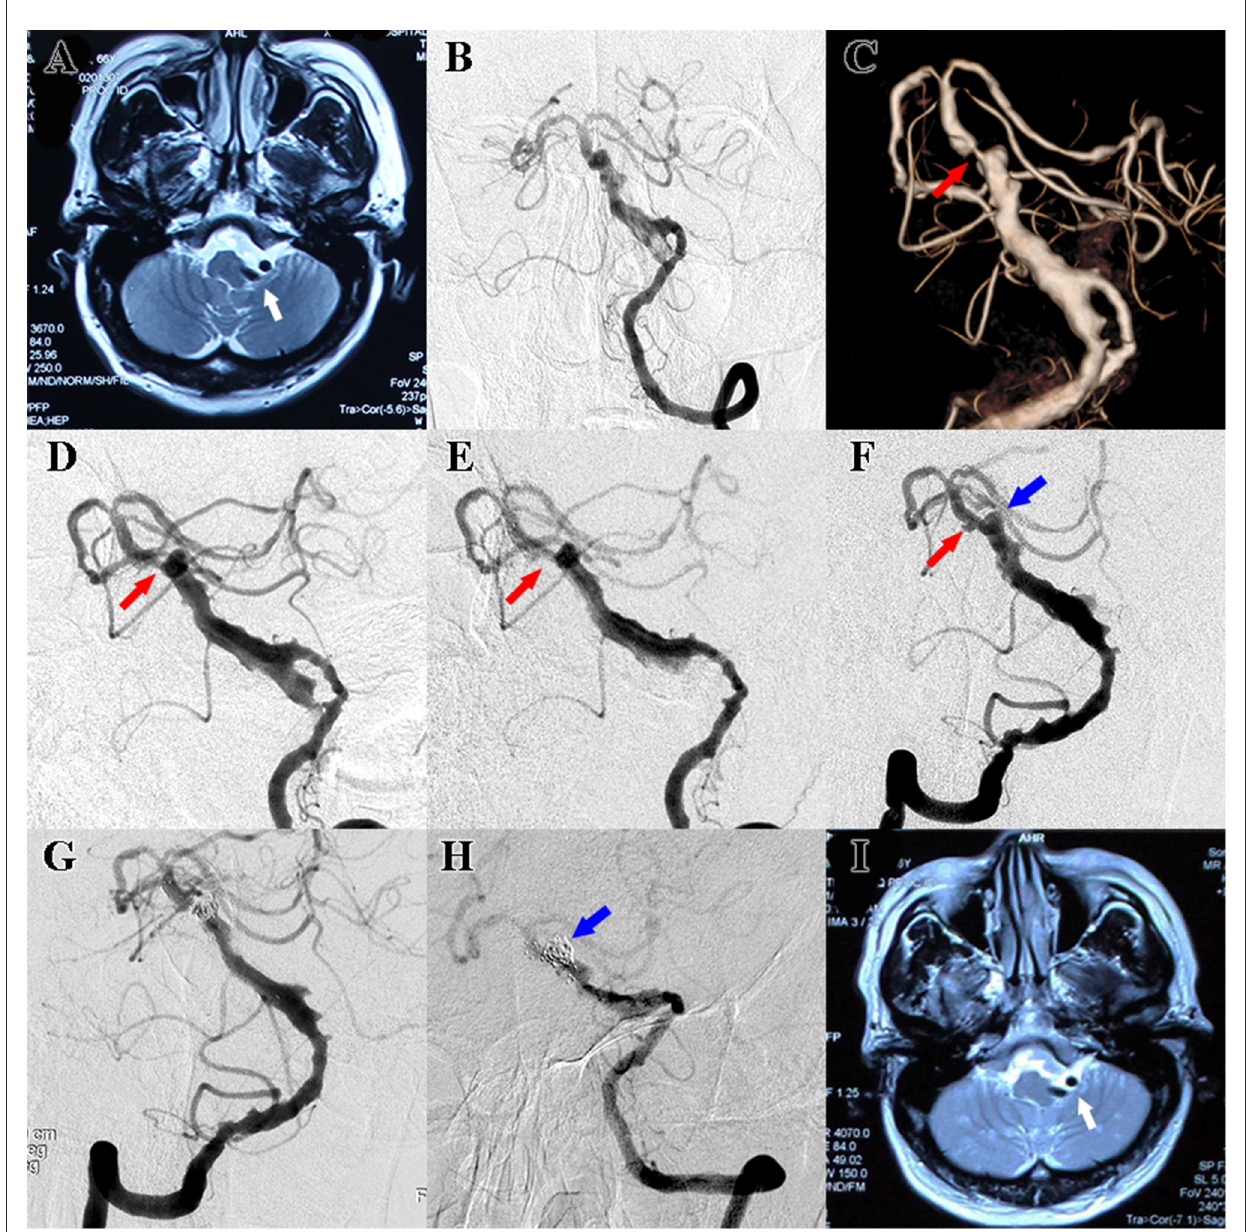
FIGURE1 (A) Preoperative T2-weighted MRI showed facial nerve compression resulting from VBD (white arrow). (B) Standard frontal view of preoperative DSA also revealed ectasia, elongation, and tortuosity of the vertebrobasilar artery, and the diagnosis of VBD was confirmed. (C) 3D volume rending reconstructed image of preoperative DSA showed severe stenosis of the basilar artery (red arrow). (D) 2D angiography of optimal view of preoperative DSA demonstrated stenosis of the basilar artery, but the degree of stenosis was less severe (red arrow). (E) Postoperative angiography after balloon angioplasty along with stent implantation showed that the stenosis was partly improved (red arrow). (F) 6-month follow-up angiography showed that the stenosis of the basilar was improved (red arrow) while the aneurysm seemed enlarged (blue arrow). (G) Postoperative angiography after stent-assisted coils embolization showed that the aneurysm was occluded (blue arrow). (H) Follow-up angiography after stent-assisted coils embolization showed that an aneurysm-like protrusion of the VBD was occluded (blue arrow). (I) Follow-up MRI indicated facial nerve compression remained (white